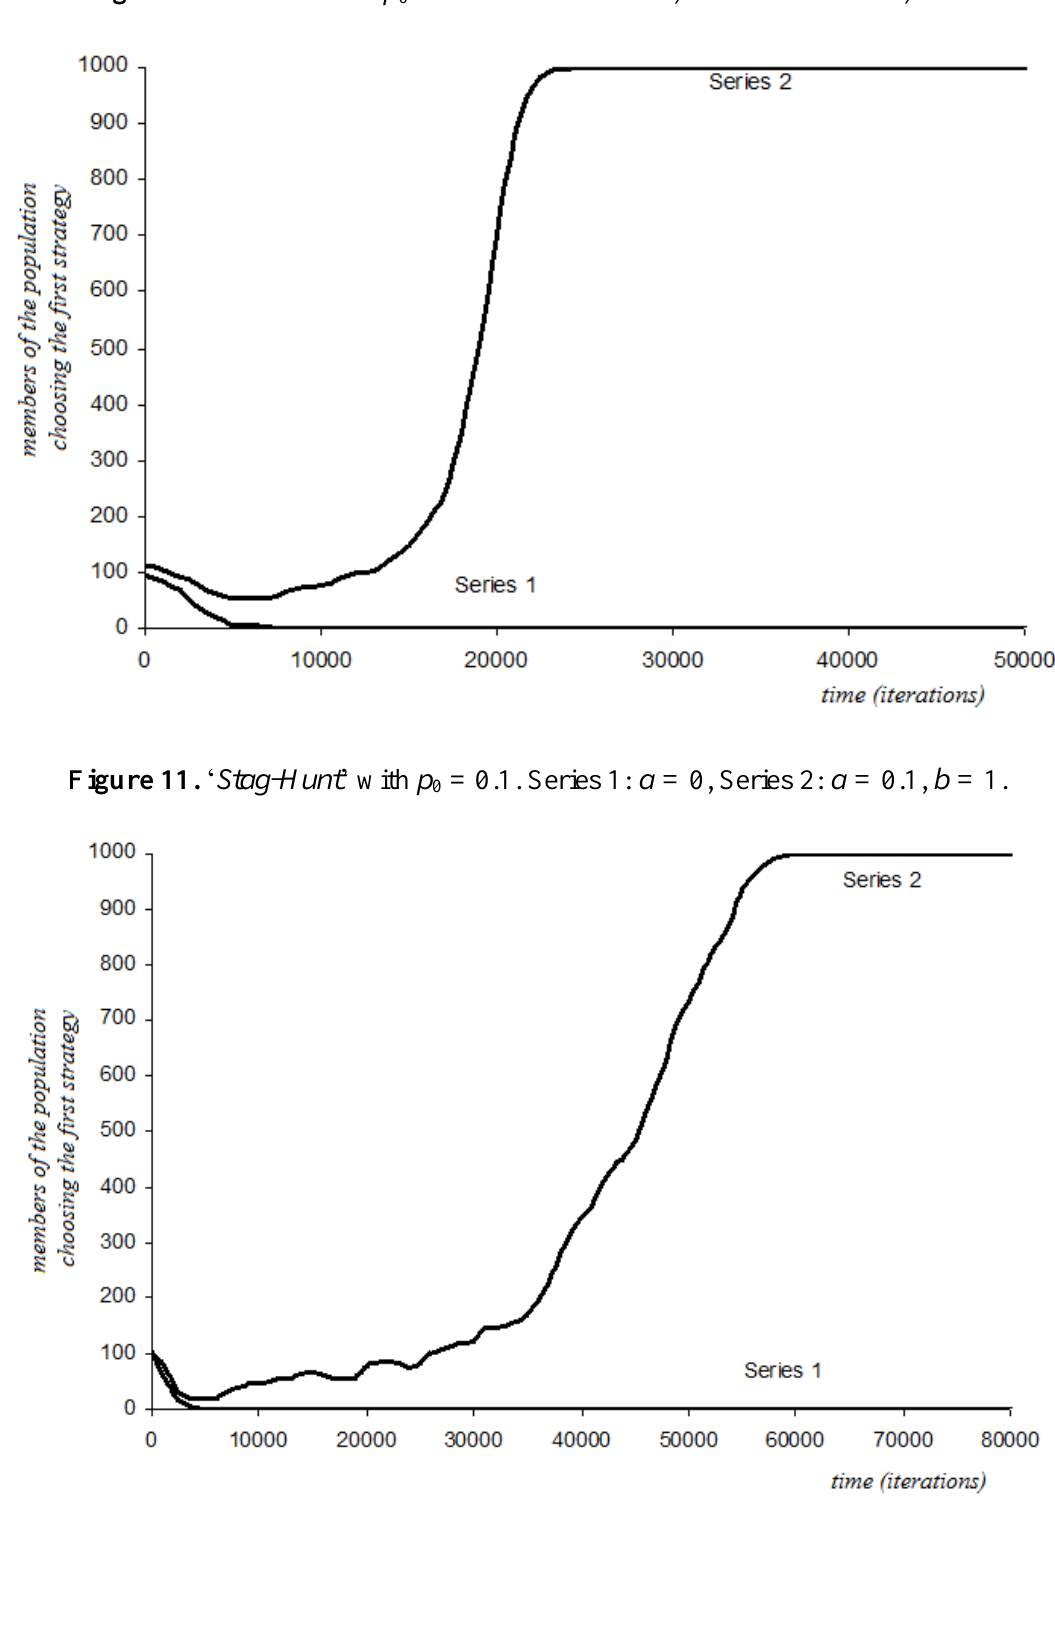
Figure 10. ‘ Hi-Lo ’ with p